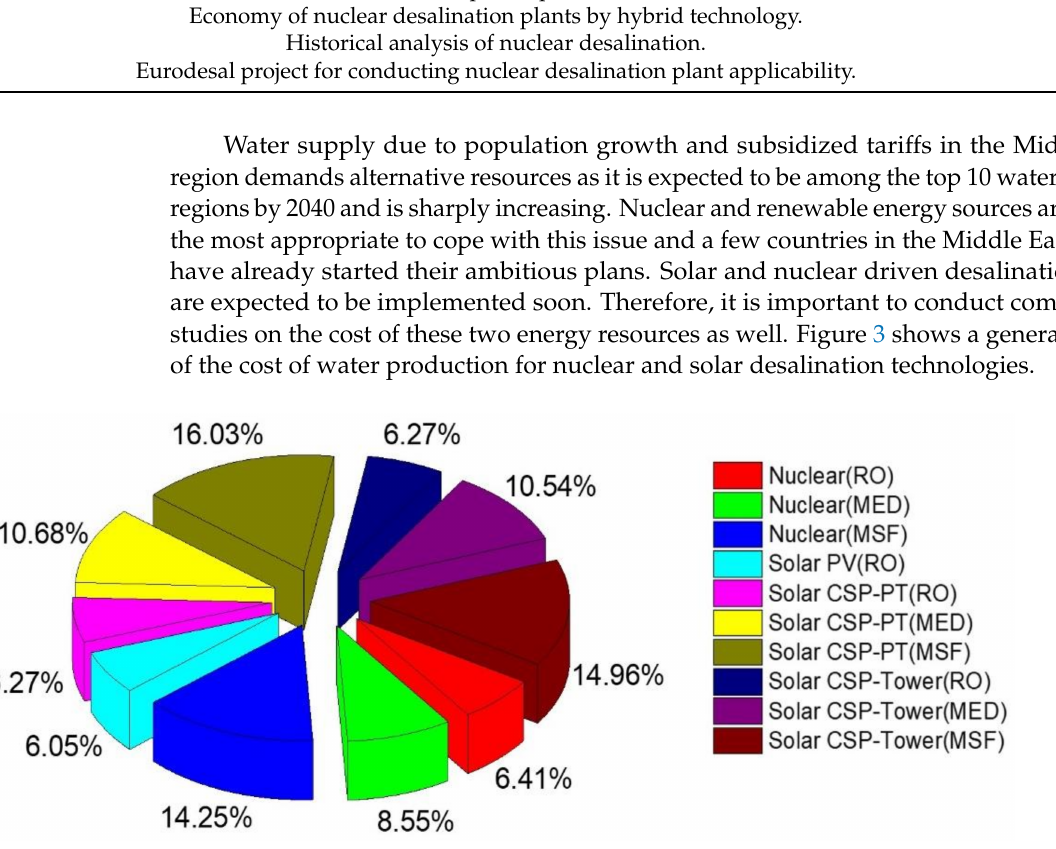
Figure 3. Water desalination cost of nuclear and solar energy coupled units [27].